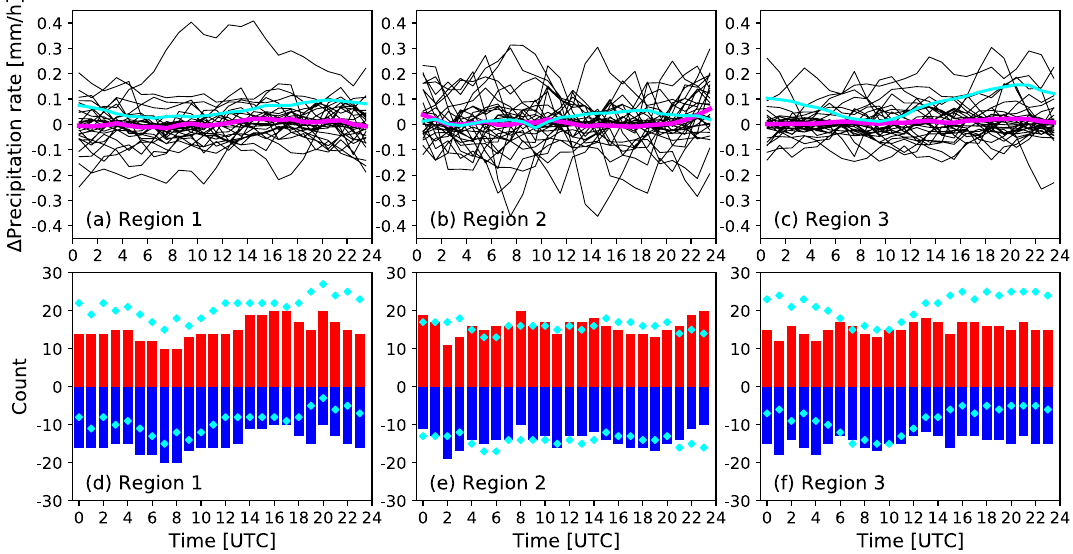
Figure 3. ( a – c ) FIRE-NOFIRE differences in hourly precipitation rate (mm h − 1 ) each day (black) and their monthly average (magenta). ( d – f ) Raw counts of increased (+ 1, red) or decreased (− 1, blue) hourly rainfall rates (FIRE-NOFIRE). All are averages over ( a , d ) Region 1, ( b , e ) Region 2, and ( c , f ) Region 3. An equivalent figure for the CHEM runs can be found in TW22. The cyan lines and markers present the equivalent data from the CHEM